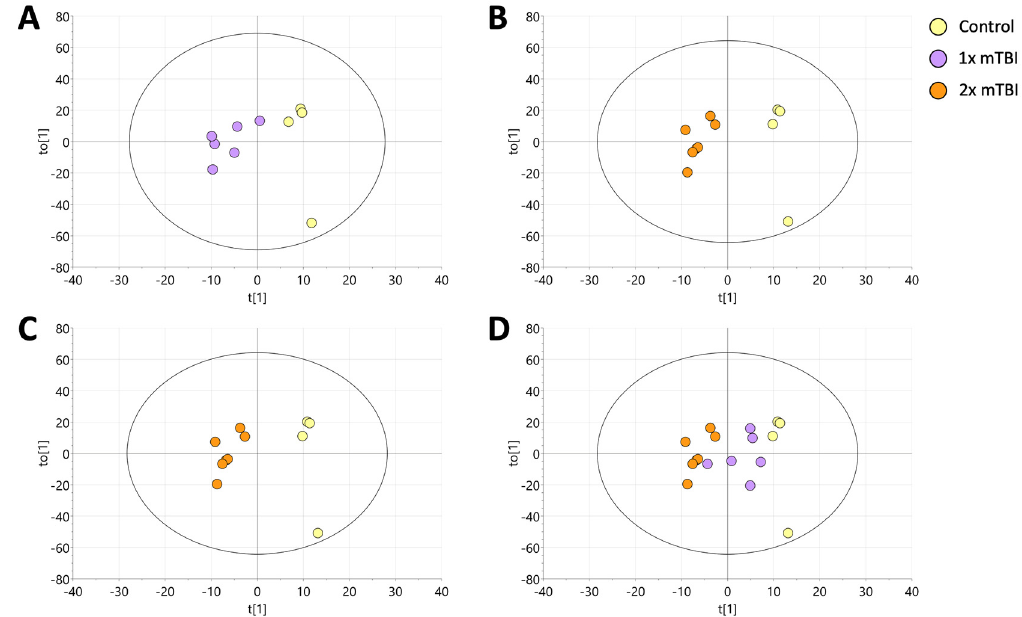
Figure 1. Orthogonal projection to latent structure-discriminant analysis (OPLS-DA) of plasma lipids following sham, 1 × or 2 × mTBI. ( A ) OPLS-DA visualisations of control samples vs. 1 × mTBI samples. ( B ) OPLS-DA visualisations of 2 × mTBI vs. 1 × mTBI. The model was scaled proportionally to R2x, R2x(1) = 0.143, R2Xo(1) = 0.415. ( C ), OPLS-DA visualisations of control vs. 2 × mTBI. ( D ) singular mTBI intervention (1 × mTBI) was projected onto the final model for validation. The model was scaled proportionally to R2x, R2x(1) = 0.0886, R2Xo(1) = 0.548. mTBI, mild traumatic brain injury.